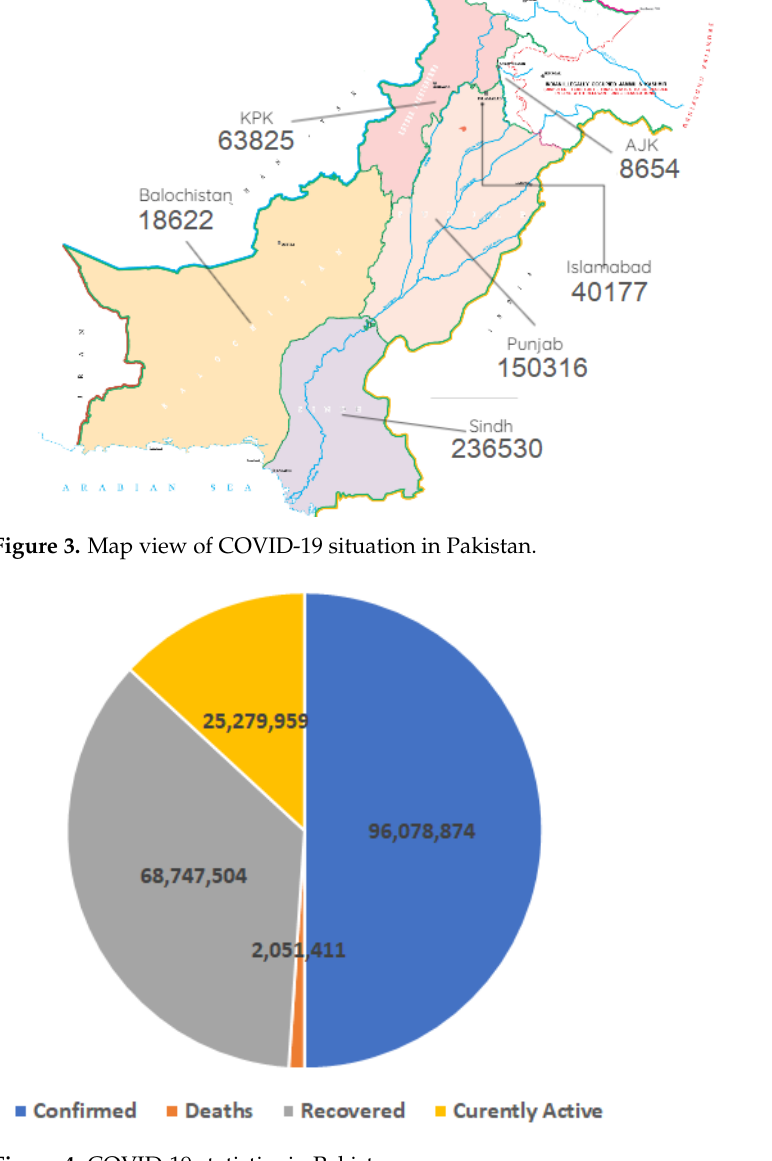
Figure 4. COVID-19 statistics in